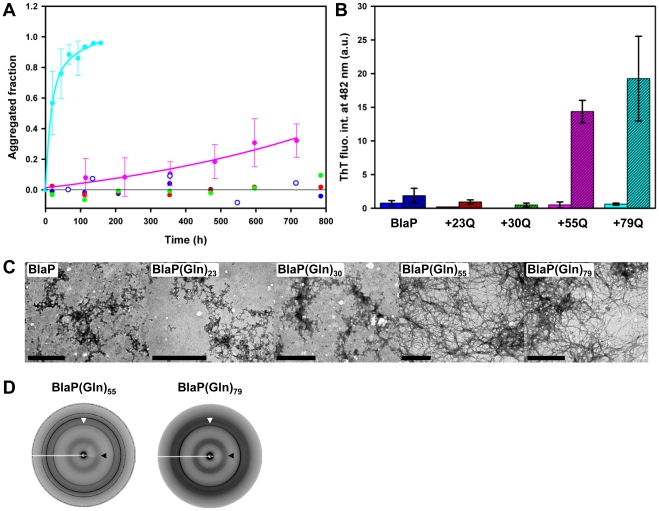
The unfolding of the β-lactamase moiety is not the critical factor that triggers the aggregation process.(A) Aggregation kinetics of 110 µM BlaP (blue), BlaP(Gln)23 (red), BlaP(Gln)30 (green), BlaP(Gln)55 (pink) and BlaP(Gln)79 (cyan) at 25°C in the presence of 3.5 M urea in PBS, pH 7.5, followed by measuring the concentration of protein remaining soluble. Time-points shown with an error bar are the average of three independent time-courses for BlaP(Gln)55 and BlaP(Gln)79. Error bars show the standard deviations. For BlaP, two independent experiments were carried out (filled and open blue circles); however, since the times at which samples were taken differ from one time-course to the other, the data could not be averaged. For BlaP(Gln)23 and BlaP(Gln)30, only one time-course was carried out. (B) ThT fluorescence intensities at 482 nm in the presence of BlaP and chimeras samples at T0 (solid bars) and Tf (dashed bars). T0 and Tf correspond to the initial and final points of one time-course for each protein. Data are the average of three measurements and error bars represent the standard deviations. a.u., arbitrary units. (C) TEM images of the protein samples at Tf. The scale bar is 1 µm. (D) X-ray fibre diffraction patterns from BlaP(Gln)55 and BlaP(Gln)79 fibrils. White and black arrows indicate meridional and equatorial reflections at 4.7 Å and ca. 9.5 Å, respectively.